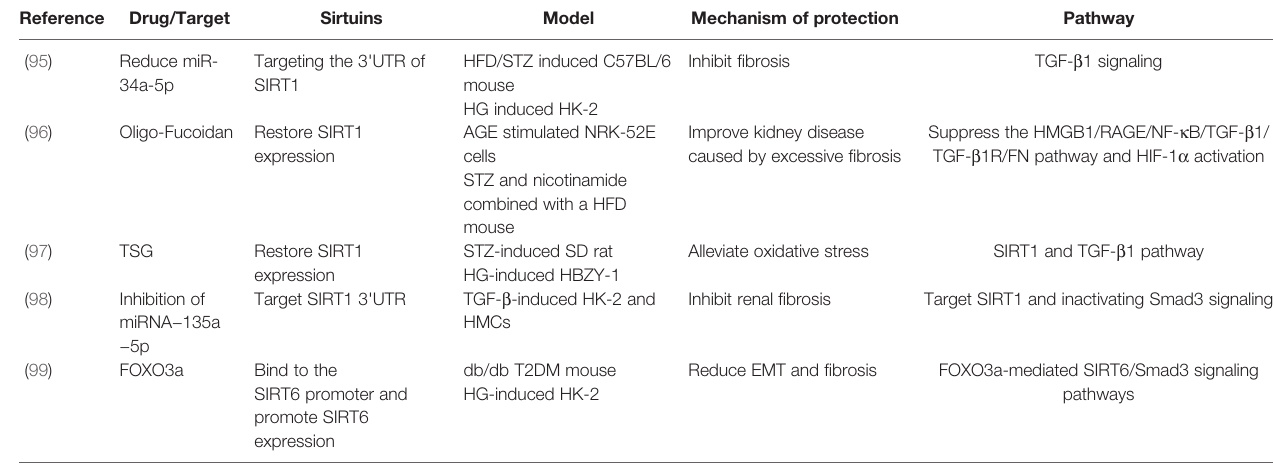
TABLE 5 | DKD studied on sirtuins and TGF- b 1/Smad3 pathway. Reference Drug/Target